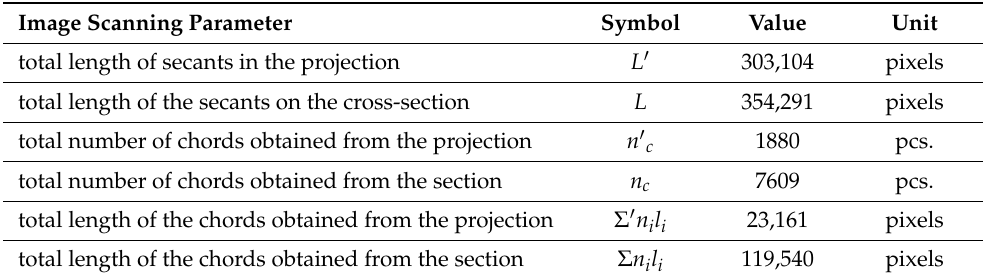
Table 2. Summary values obtained from vertical and horizontal image scan data. Image Scanning Parameter